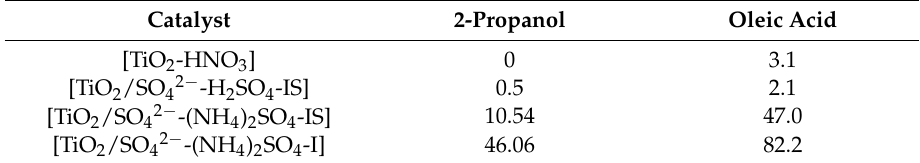
Table 2. Conversion of 2-propanol and oleic acid esterification on sulfated titania. Catalyst